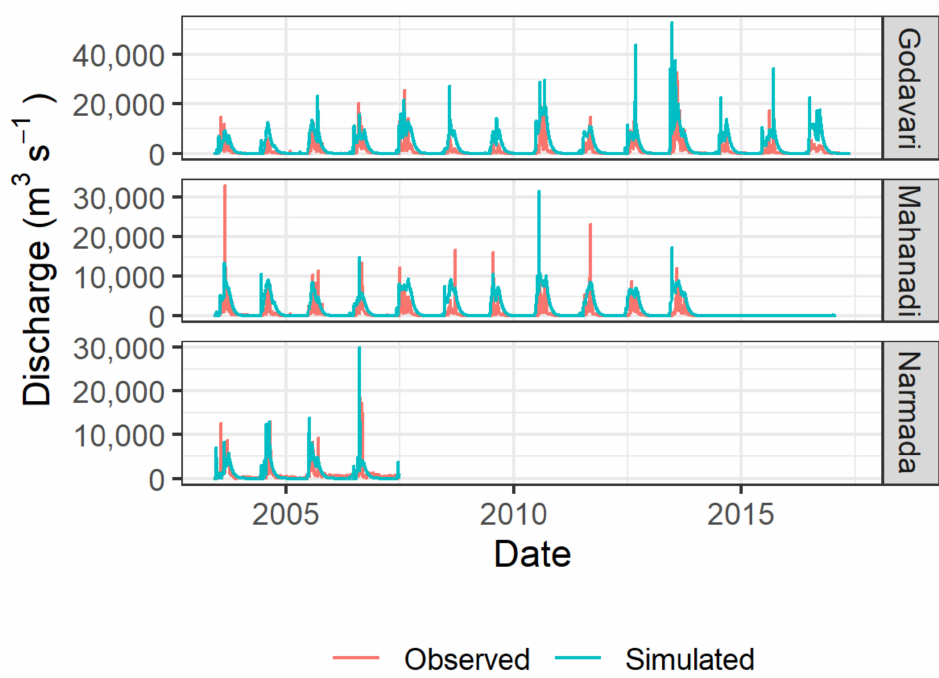
Figure 2. Observed versus daily simulated discharge for the three river basins with available discharge data for the study